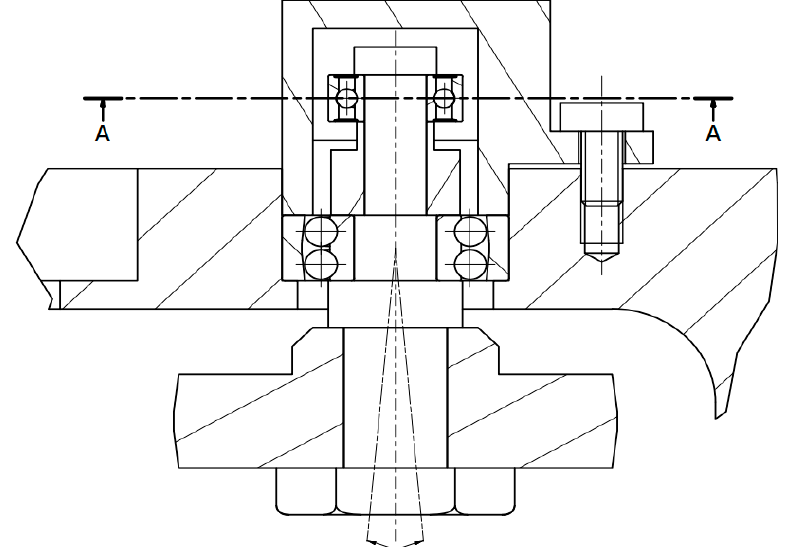
Figure 6. Detailed drawing of the intermediate friction wheel mechanism: the shaft can deflect around the self-aligning ball bearing center. The movement is limited to just one plane due to the ball bearing seated in the top of the shaft with its outer ring seated in an oblong as shown, in Section “A-A” (Figure 7).